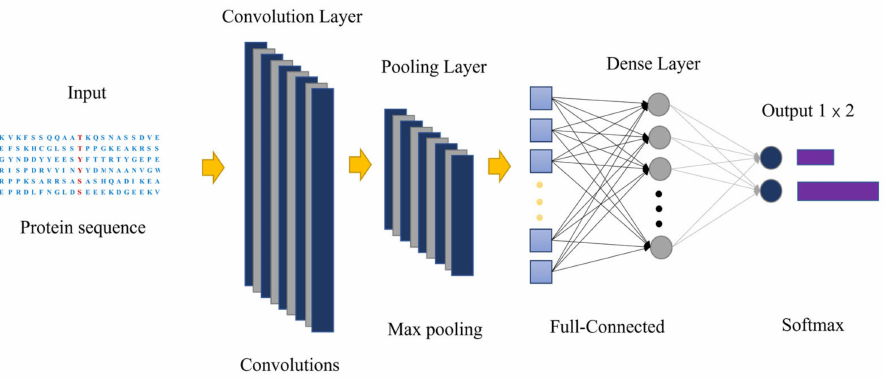
Figure 7. The architecture of deep convolutional neural network for leukemia-related phosphoryla- tion sites